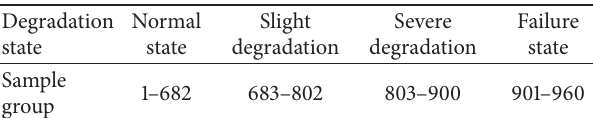
Table 1: The experimental parameters. Table 2: The division of degradation state of rolling bearing